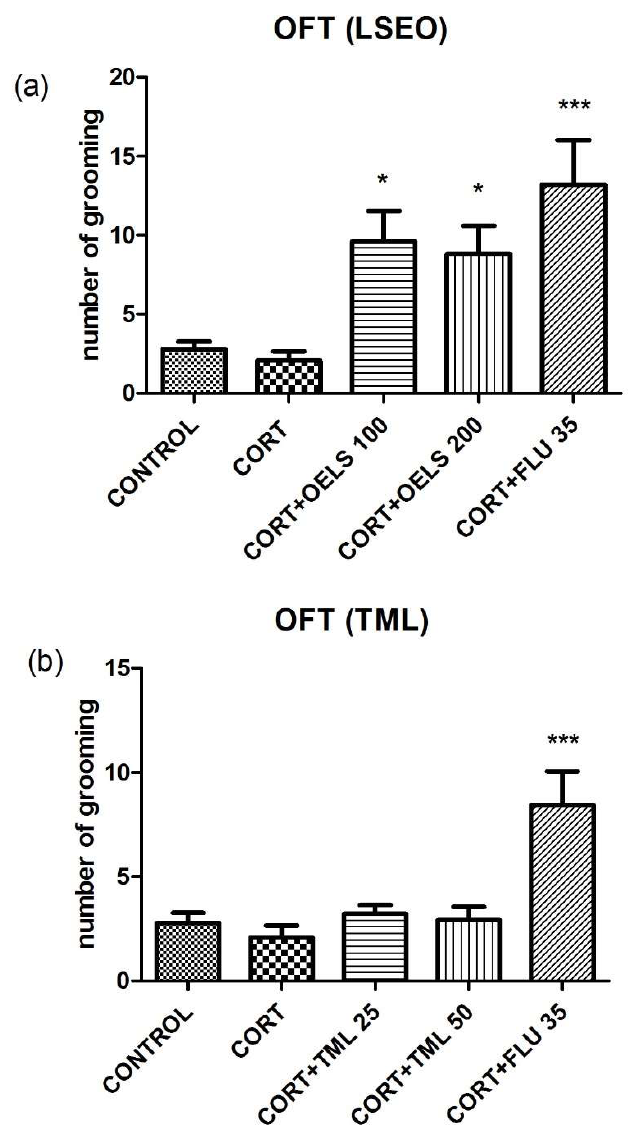
Figure 7. Effects of repeated administration of ( a ) LSEO (100 and 200 mg/kg; p.o.) and ( b ) TML (25 and 50 mg/kg; p.o.) in animals treated with CORT (22 days, 20 mg/kg, s.c.) on the number of grooming behaviors on the OFT. Values are expressed as the mean ± SEM ( n = 10). Statistical analysis was determined by one-way ANOVA followed by Student-Newman-Keuls test.